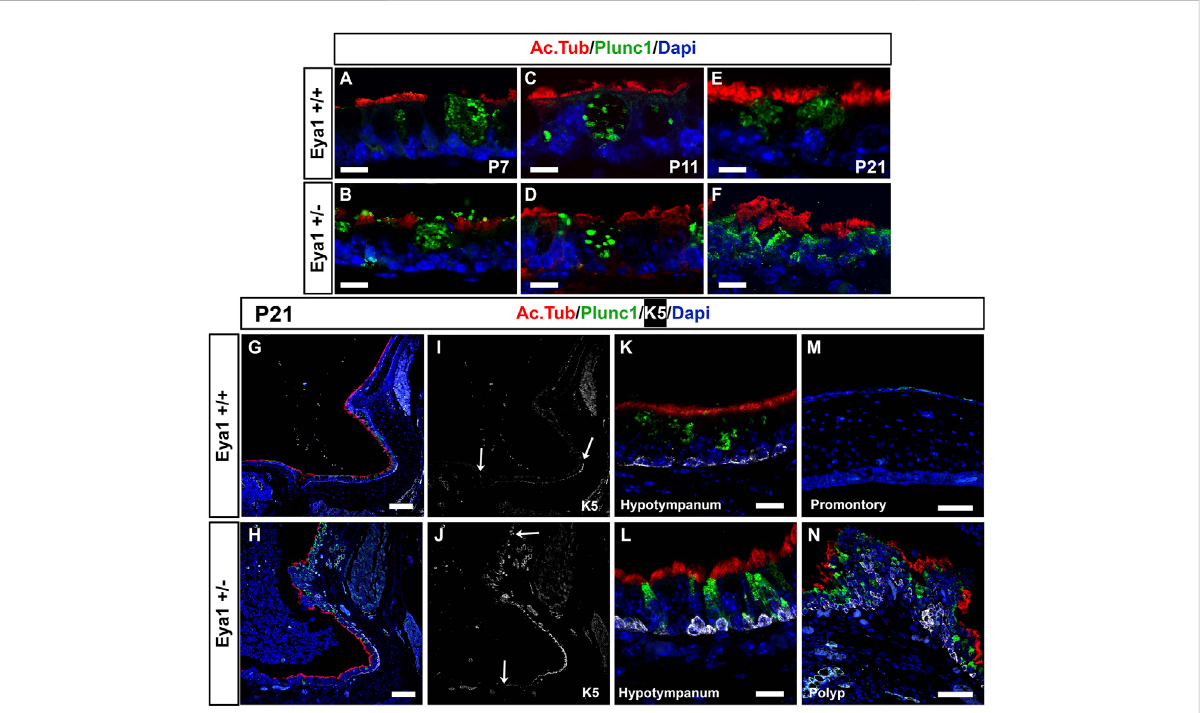
FIGURE 4 Defects in secretory and ciliated cells are a consequence of OM. Immuno fl uorescence for acetylated tubulin (red) to label ciliated cells, for Plunc1 (green) for secretory cells and keratin 5 (white) for basal epithelial cells. (A,B) P7. (C,D) P1. (E – H) P21. Wild-type littermates (A,C,E,G,I,K,M) . Eya1 heterozygotes (B,D,F,H,J,L,N) . (A – F,K,L) Hypotympanum. (M,N) Promontory. (A – D) Secretory cells (green) and ciliated cells (red) appear normal at P7 and P11, before the onset of OM. (E,F,K,L) Secretory cells and ciliated cells have disrupted morphology in the hypotympanum by P21 after the onset of OM. (K,L) Keratin 5 (K5) positive cells (white) in the hypotympanum were associated with the basal epithelium, in both WT and hets. (G,H) The cilia (red) along the promontory becomes patchy compared to the wild-type, and the secretory cells, which are usually restricted aroundtheeustachiantube,wereexpressed all theway alongthepromontory. (I,J) Same sectionasin (G,H) showing expression ofKeratin5(white). Arrow at bottom of images indicates position of eustachian tube. (I) In the wild-type keratin 5 basal cells do not extend up towards the promontory. (J) IntheheterozygousmicecellsexpressingK5areexpandedreachingthepromontoryincasesofOM(Comparetoparrows,inI,Jtoindicateextent of labelled cells). (M) The wild-type promontory epithelium does not express keratin 5 or Plunc1. (N) Polyps were evident on the promontory in mutant mice with OM. These polyps contained K5 positive cells in suprabasal layers, with very disrupted cilia and an increase of secretory cells